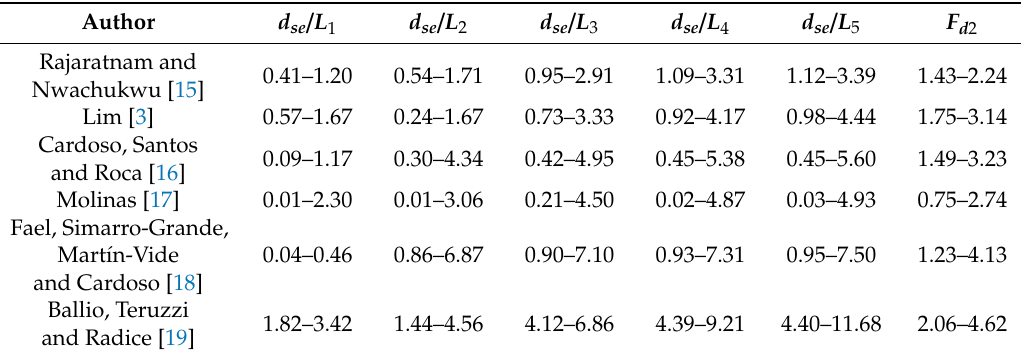
Table 3. Summary of dimensionless experimental ranges.